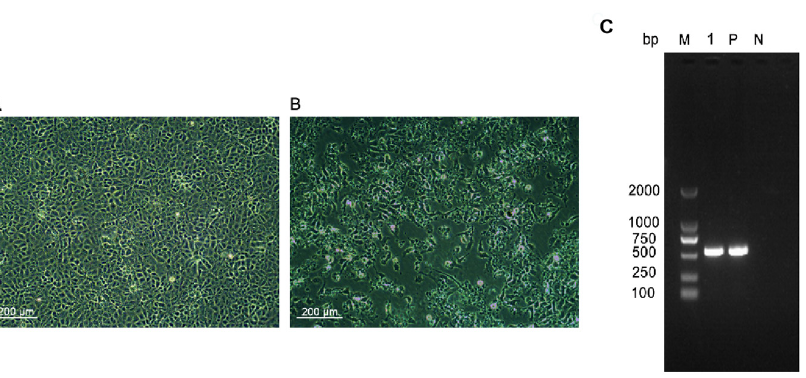
Figure 1. Detection of IPNV in diseased rainbow trout. ( A ) Negative control; ( B ) CPE caused by IPNV in CHSE cells were characterized at 4 d. ( C ) IPNV PCR analysis. M, DL2000 Marker; 1: sample; P, positive control; N, negative control.